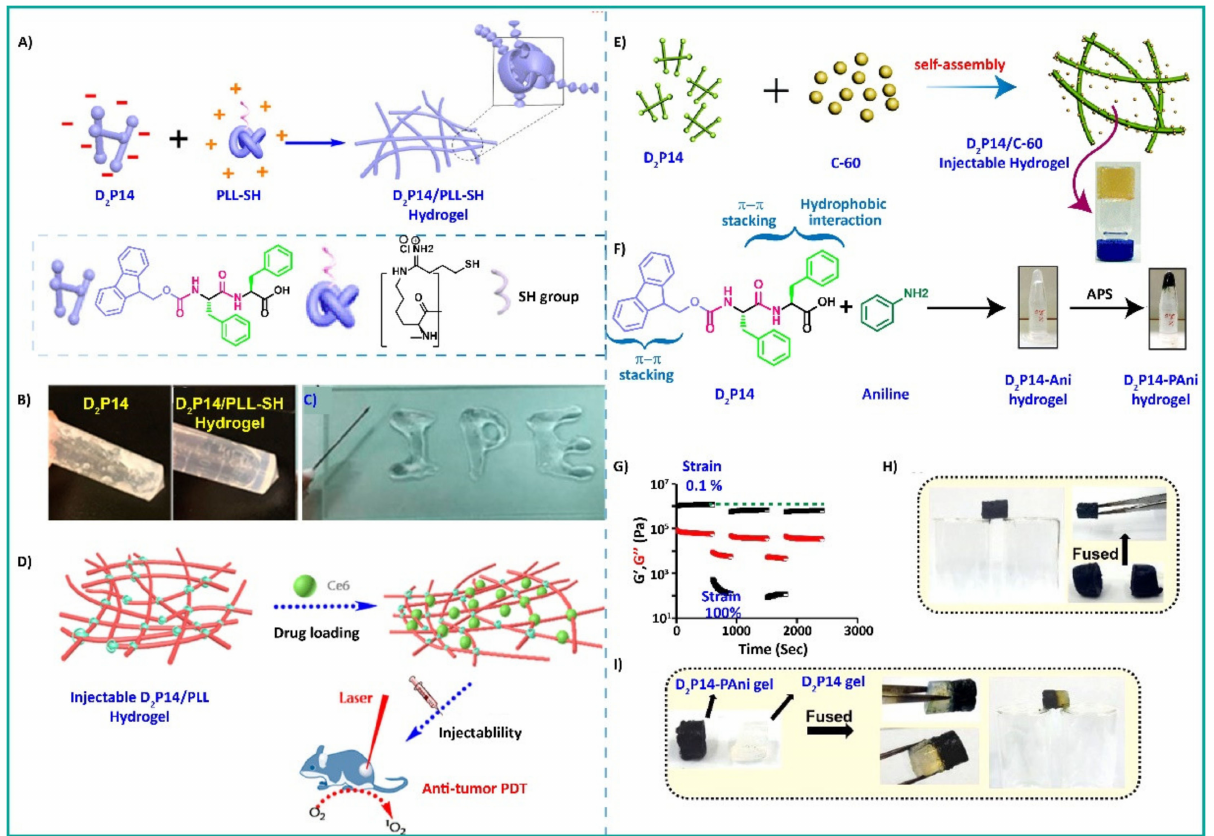
Figure 18. ( A ) Schematic illustration of the D 2 P14/PLL-SH composite hydrogel. ( B ) D 2 P14 hy- drogel showing separation of water and gel; D 2 P14/PLL-SH hydrogel. ( C ) Injectability behavior of the D 2 P14/PLL-SH hydrogel; reproduced with permission from Ref. [171]. Copyright (2017) American Chemical Society. ( D ) Schematic representation of injectable D 2 P14/PLL hydrogels for delivery of Ce6 and anti-tumor PDT; reproduced with permission from Ref. [172]. Copyright (2018) American Chemical Society. ( E ) Schematic sketch of D 2 P14/PLL-SH injectable hydrogel with vial inverted photograph; reproduced with permission from Ref. [173]. Copyright (2018) Royal Society of Chemistry. ( F ) Chemical structure, photographs of D 2 P14/PAni composite hydrogel. ( G ) Rheology experiment confirming the thixotropic behavior of D 2 P14/PAni. ( H , I ) Self-healing behavior of D 2 P14 and D 2 P14/PAni hydrogels; reproduced with permission from Ref. [174]. Copyright (2019) American Chemical